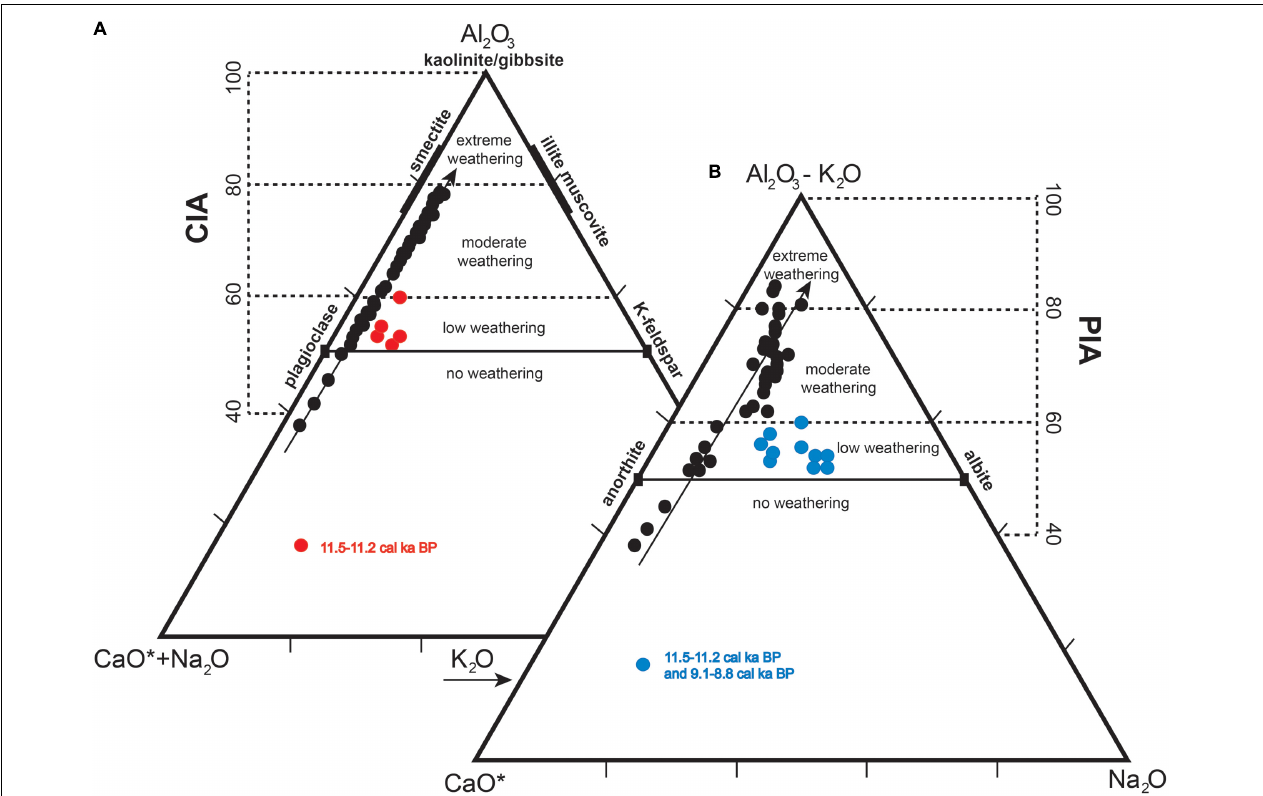
FIGURE 7 | Sediment compositions plotted as molar proportions of Al 2 O 3 , (CaO* + Na 2 O) and K 2 O in A–CN–K ternary diagram (A) and molar proportions of Al 2 O 3 (subtracting the Al associated with K), CaO* and Na 2 O in the A–C–N ternary diagram (B) . CaO* represents the concentration of CaO in silicates and alumino-silicates. CIA and PIA show the degrees of chemical weathering of feldspars and plagioclase, and the samples deviating from the lines with arrow indicate change in